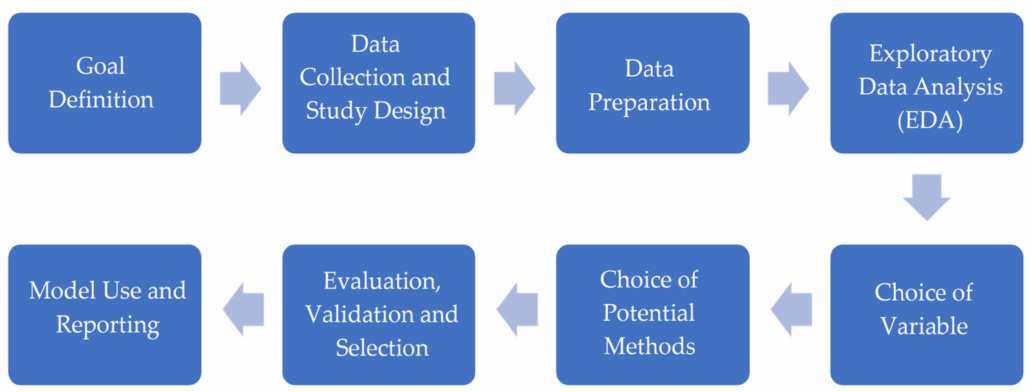
Figure 1. Empirical model-building steps schematic. Adapted from Shmueli and Koppius